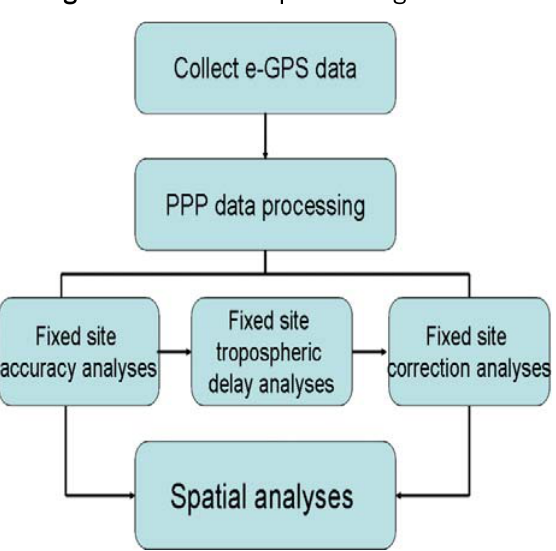
Figure 8. GPS data processing